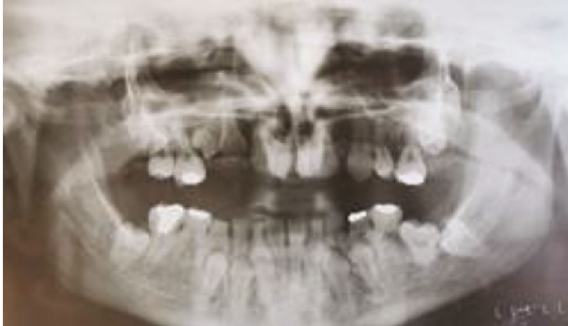
Figure 2: Panoramic radiograph taken at age of 16 before orthodontic